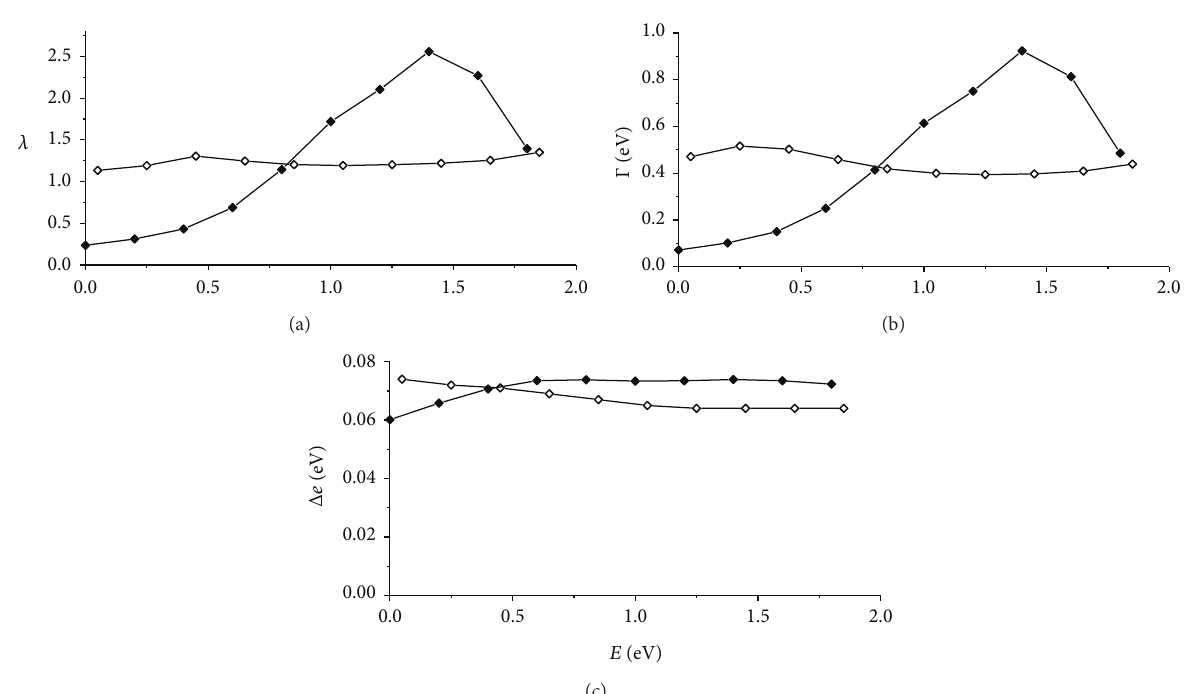
Figure 2: The mean characteristics of the hole-phonon (empty rhombus) and electron-phonon (black rhombus) relaxation for anatase as functions of the excess energy 𝐸 . Here 𝜆 is the constant of interaction, Γ is the rate of energy loss according to (7) and (11), and Δ𝑒 is the mean energy lost with emission of one phonon, in accordance with (9), (12), and (13).